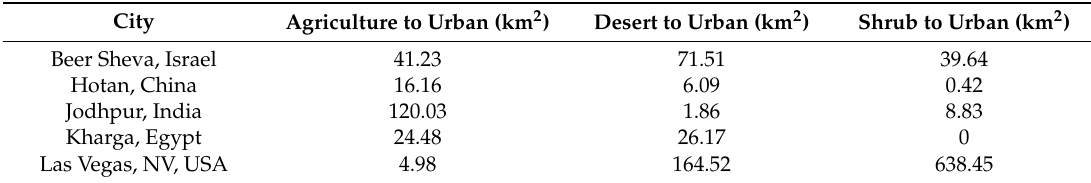
Table 3. Land conversions from other LCLU types to urban.